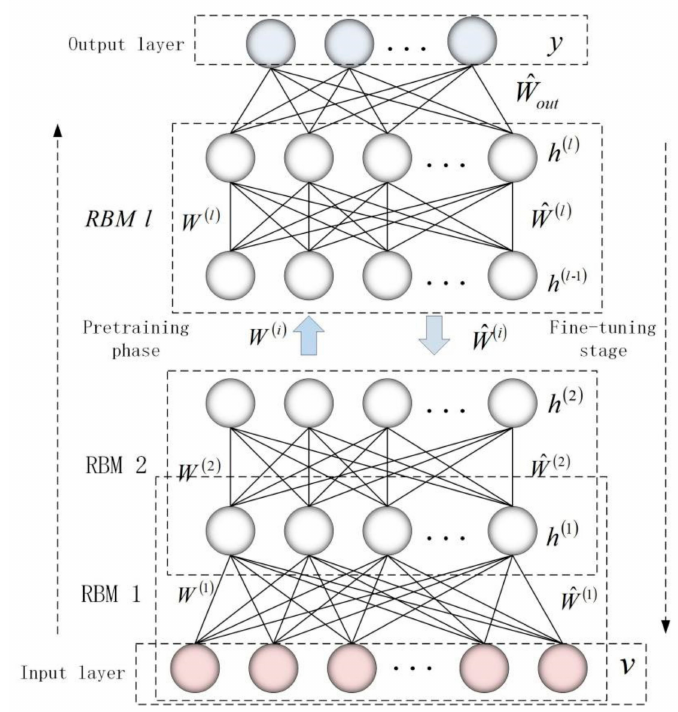
Figure 1. The basic structure and learning process of deep belief network